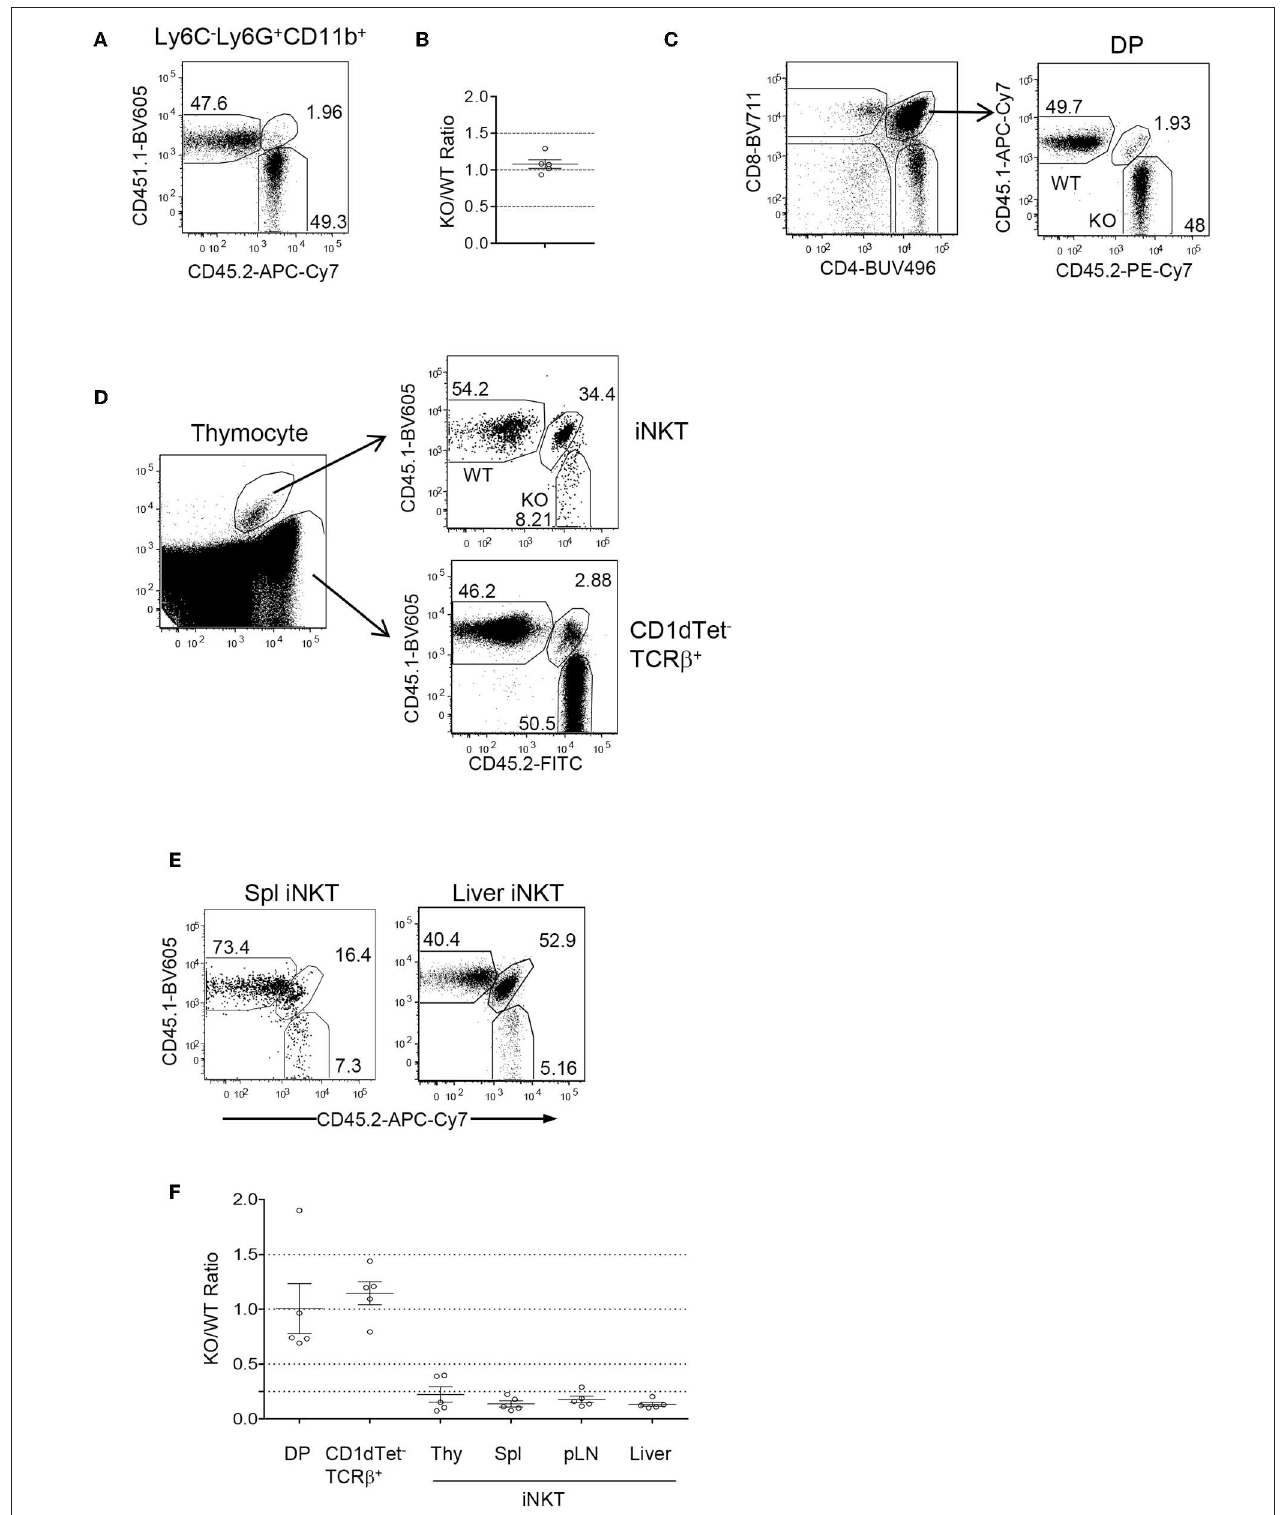
FIGURE 2 | Intrinsic control of i NKT cell development by Foxo1. CD45.1 + CD45.2 + WT mice were irradiated with 800rad X-ray and intravenously injected with a mixture of CD45.1 + WT and CD45.2 + Foxo1 f / f -Cd2iCre BM cells at a 1:1 ratio. Recipient mice were euthanized and analyzed 2 months after